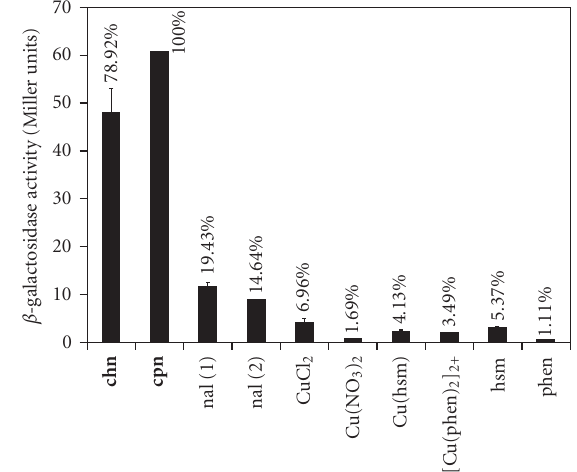
Figure 5: : Maximum levels of rec A-directed β -galactosidase induction obtained as response of the addition of the [Cu(hsm)(nal)H 2 O]Cl · 3H 2 O (chn), [Cu(phen)(nal)H 2 O]NO 3 · 3H 2 O, (cpn) complexes, or some of their molecular components on cultures of B. subtilis YB3001. Percentage indicated as comparison to the highest activity encountered (cpn =